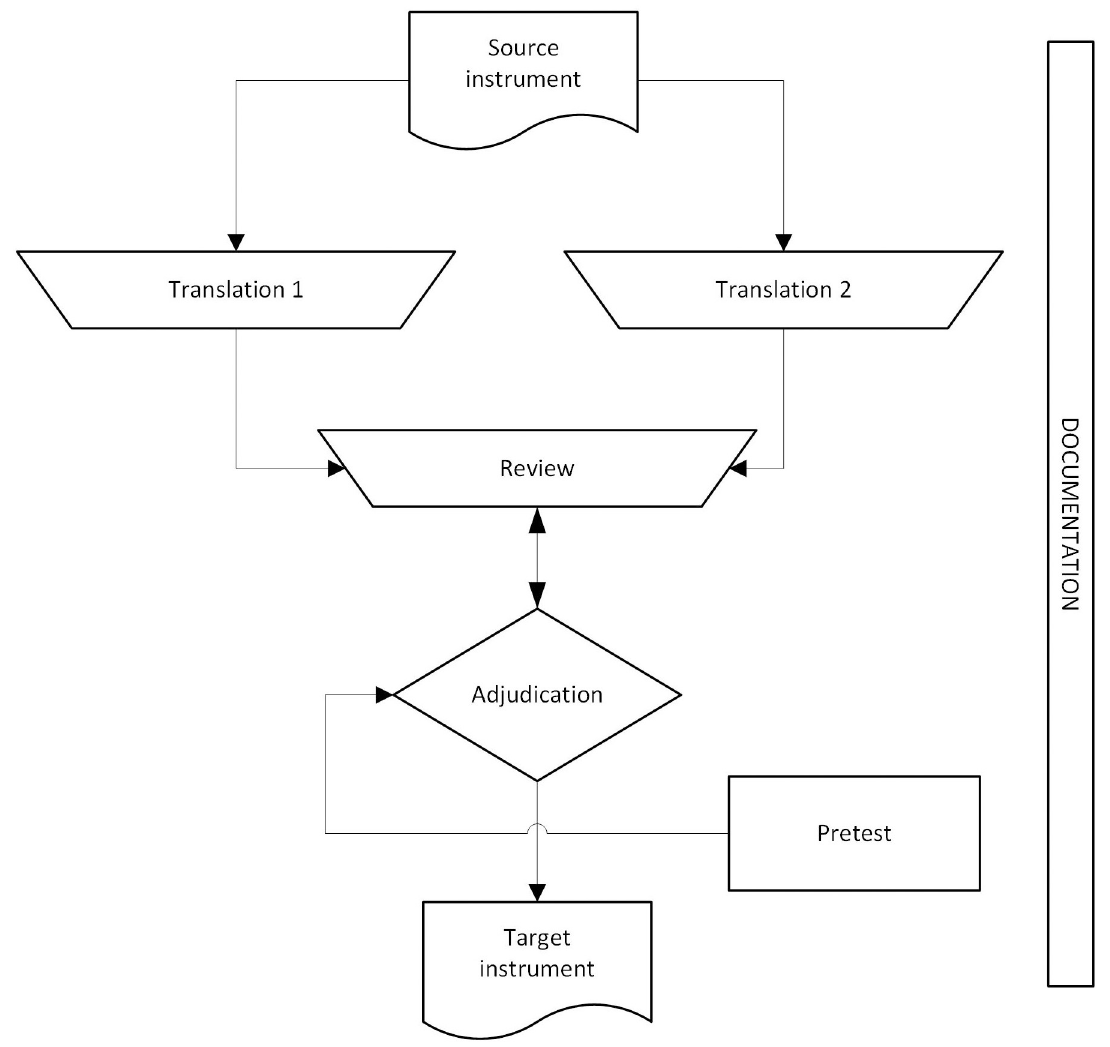
Fig 1. Illustration of the TRAPD model adapted from the Guidelines for Best Practice in Cross-Cultural Surveys [22].